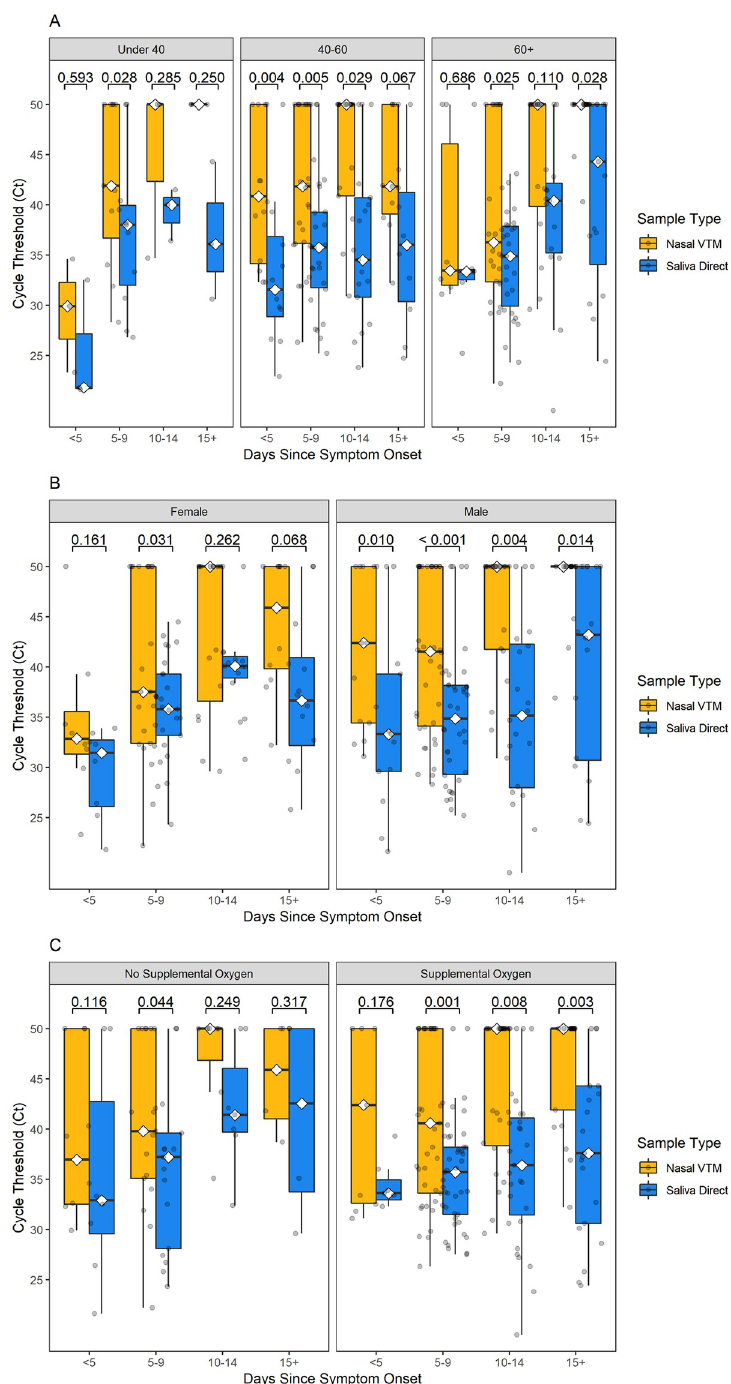
Fig 5. Sub-analysis of SARS-CoV-2 longevity by age, sex, and oxygen requirements. Sub-analysis of Ct values by days since symptom onset for saliva (blue) and nasal (orange) specimens among the overall analysis cohort based on (A) age, (B) sex, and (C) need for oxygen support.